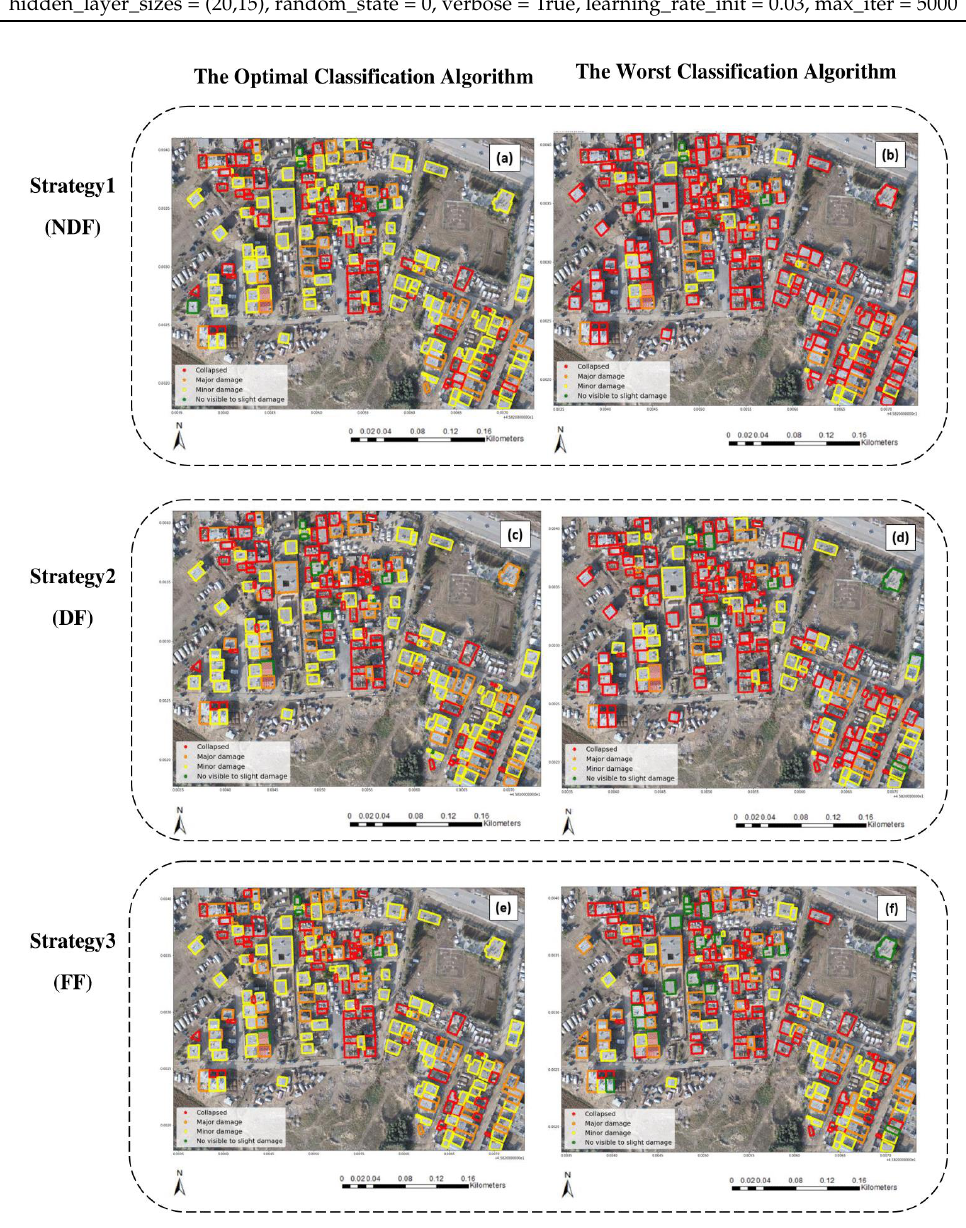
Figure 7. The best and worst buildings’ damage maps using three different feature strategies and eight AI-based classification algorithms: ( a ) GB (NDF), ( b ) AB (NDF), ( c ) MLP (DF), ( d ) AB (DF), ( e ) SVM (FF), ( f ) AB (FF).